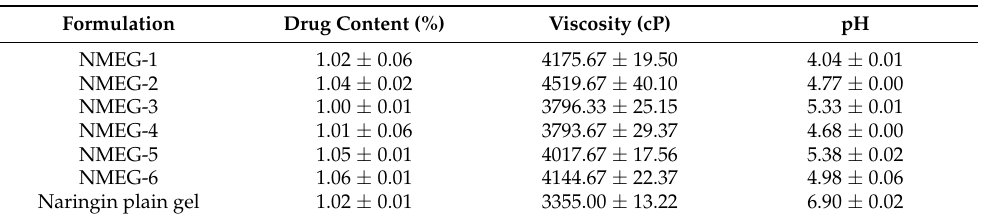
Table 4. Characterization of naringin-loaded microemulsion-gel formulations and naringin plain gel. Data represent the mean ± SD (n = 3).